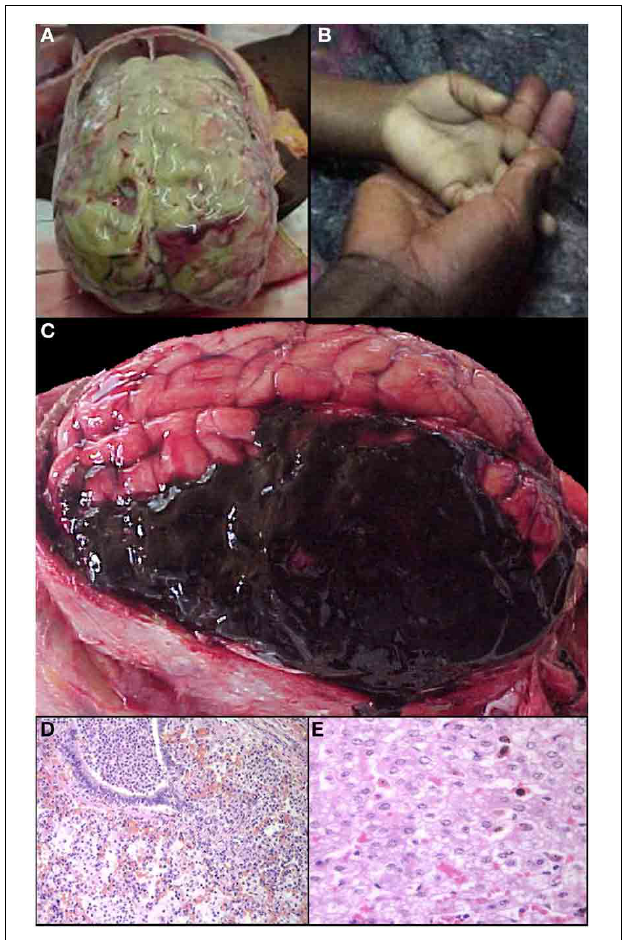
FIGURE 5 | A summary of representative images from the gross and histological examinations of the brain and other organs in the autopsy series is shown for control and non-CM cases. Meningitis (A) , one of the exclusion criteria for the clinical case definition, and severe malaria anemia (B —clinical photograph of a child’s hand in mother’s hand at admission) served as controls in the study. Intracranial hemorrhages (C) were a cause of death in several patients who met the clinical case definition for CM but without brain sequestration. Other causes of death in patients meeting the clinical case definition of CM but without evidence of brain sequestration included pneumonia (D) and Reye’s syndrome (E Whitten et al.,